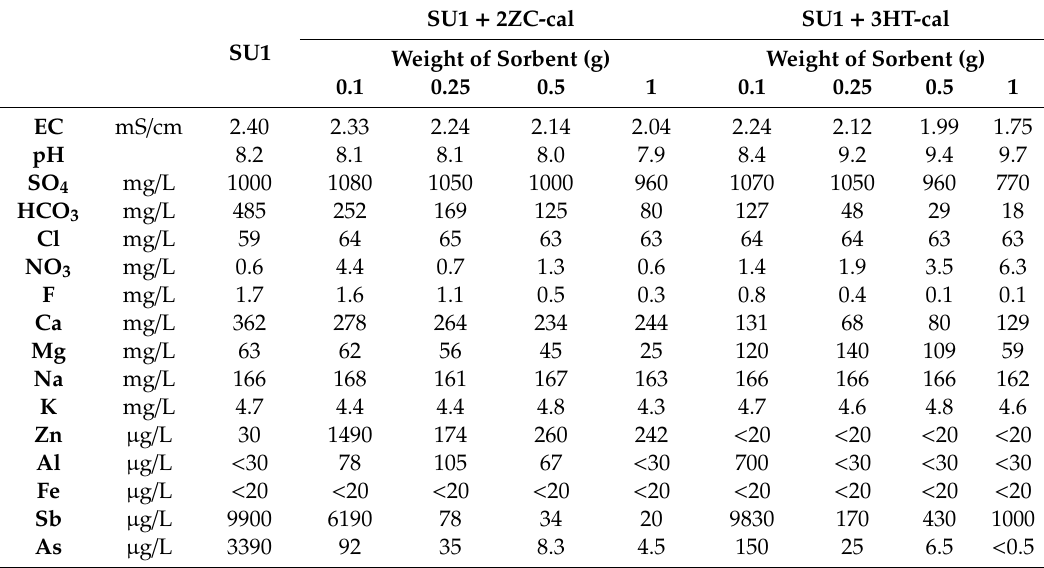
Table 5. The pH values, electrical conductivity (EC) and chemical composition of SU1 slag drainage before (SU1 column) and after the sorption experiments performed with di ff erent amounts (0.1,